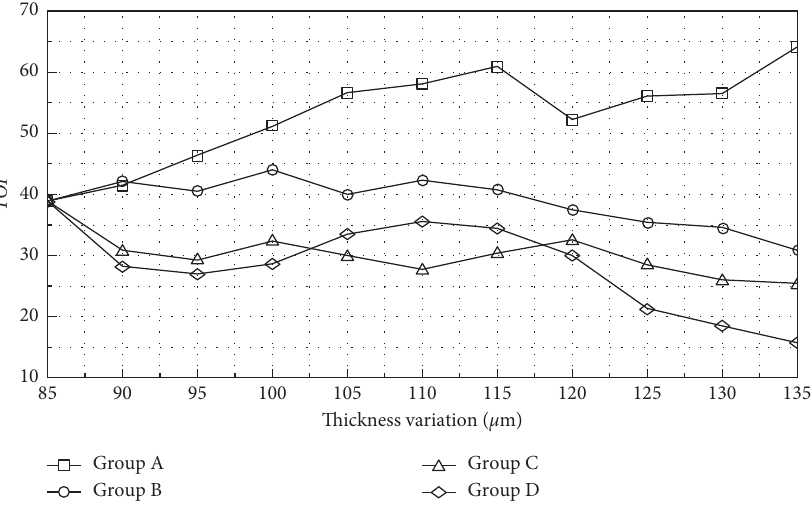
Figure 6: TOI curve for each group.